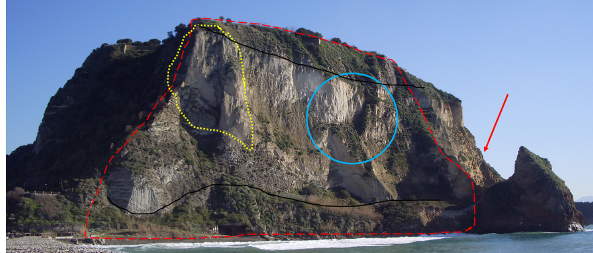
Figure 2. Coroglio cliff view from the WSW. The red dashed line shows the area mapped in Fig. 3, the yellow dotted line shows the area involved by reinforcement works, the light blue circle shows the area with unstable tuff blocks and the red arrow shows the de- tachment area of the failure that occurred around 1990, located out- side the area mapped in Fig. 3. Black lines separate the upper, me- dian and lower parts of the